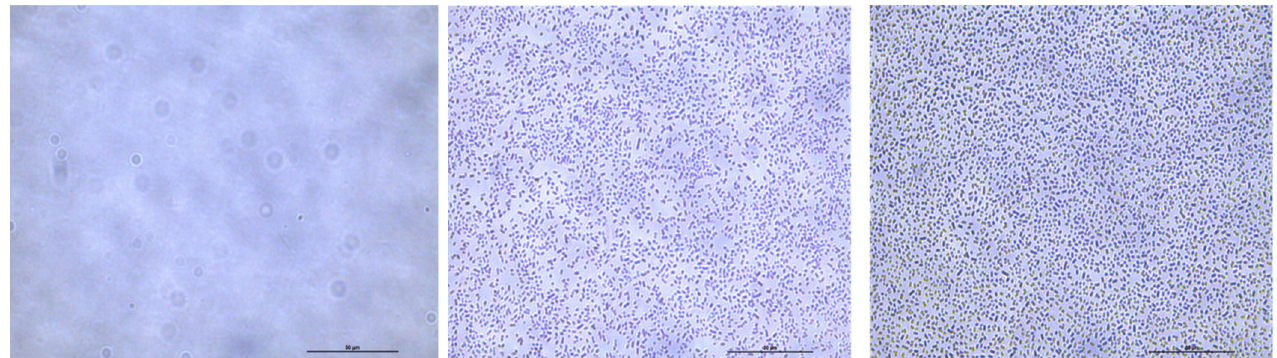
Figure 6: Crystal violet Staining of K. pneumoniae Biofilm Figure 6. Crystal violet Staining of K. pneumoniae